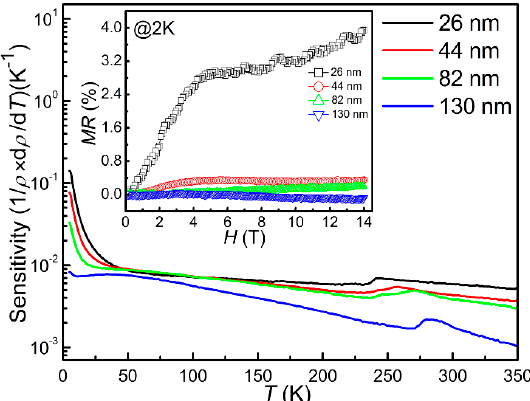
Figure 11. Zero-field sensitivity versus temperature of CrN thin film with different thickness. The magnetoresistance at 2 K is shown in the corresponding